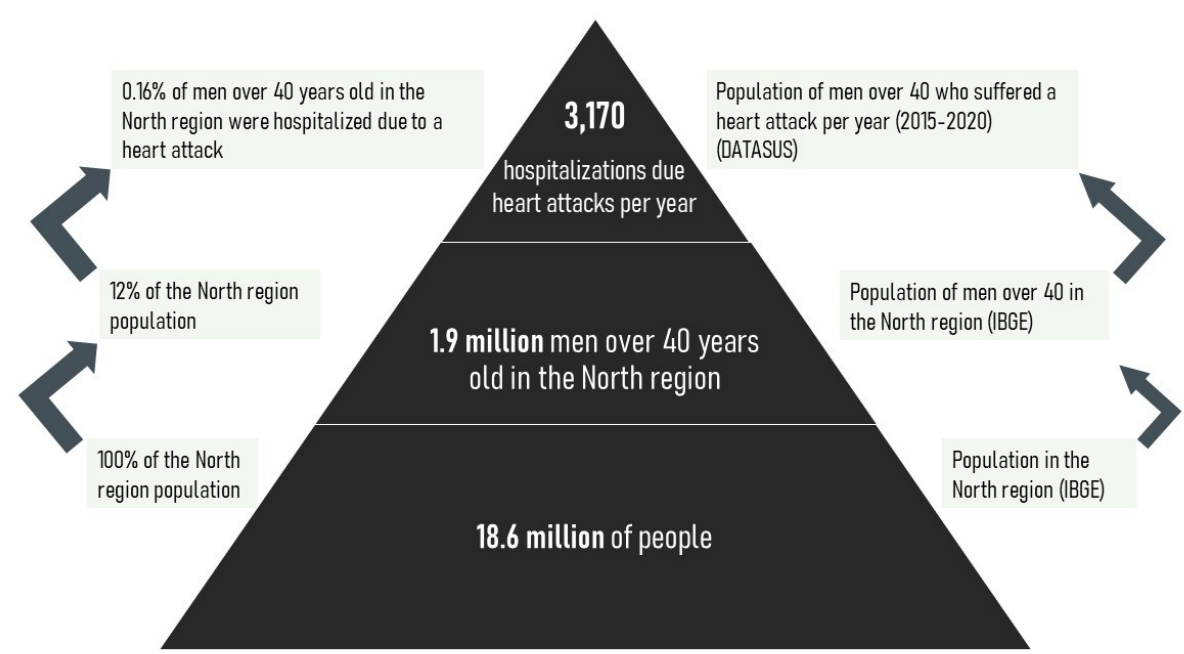
Figure 2. Outcome of myocardial infarction associated with mercury ingestion.